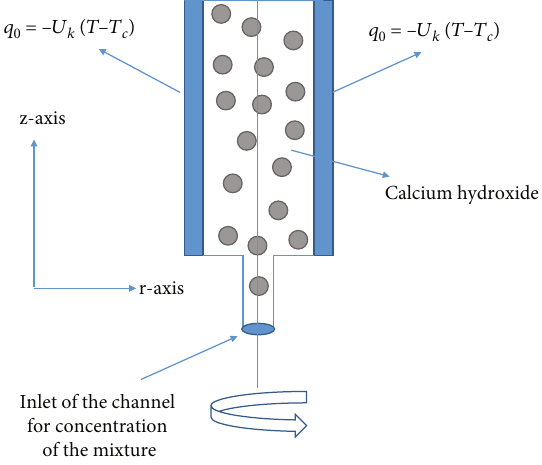
Figure 1: The geometry of the backward step channel and the boundary